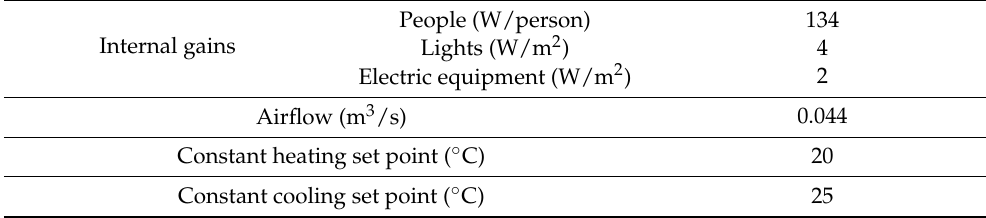
Table 3. Main thermal properties of the dwelling.